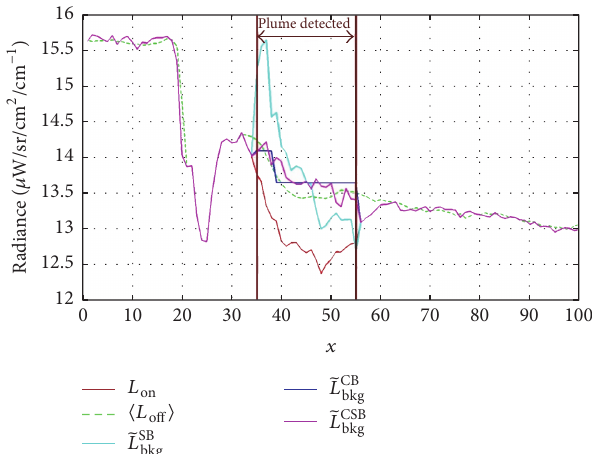
Figure 16: Comparison of different radiances at the ethylene absorptive band ( 950.4 cm −1 ), along a horizontal cross section containing some plume-present pixels. The red curve stands for the on-plume radiances; the green dashed one is the expected background radiances. The cyan, blue, and magenta curves represent, respectively, the background radiances estimated by the SB, CB, and CSB